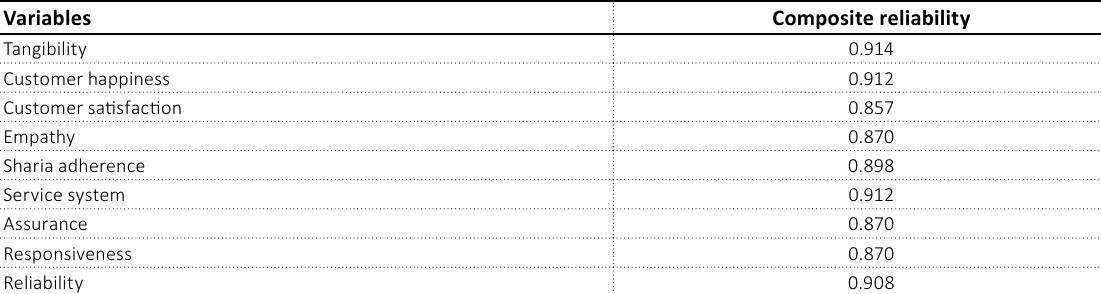
Table 4. The results of the composite reliability test